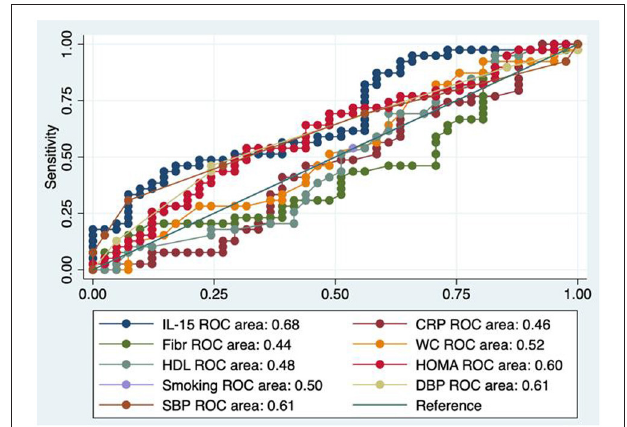
FIGURE 2 | Test equality of more ROC areas. IL-15, interleukin-15; Fibr, fibrinogen; CRP, C reactive protein; WC, waist circumference; SBP, systolic blood pressure; DBP, diastolic blood pressure; HOMA, homeostatic metabolic assessment; HDL, HDL